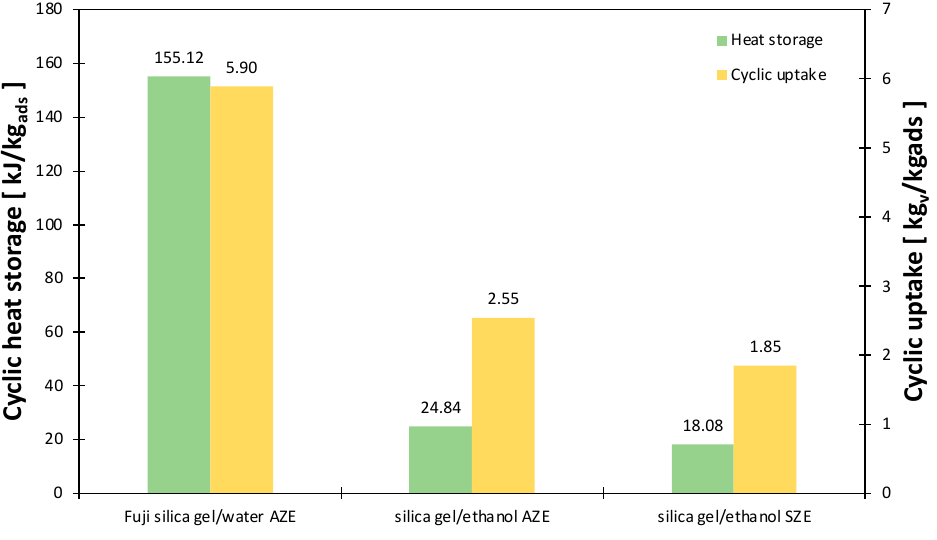
Figure 7. Heat charging/discharging cyclic performance.